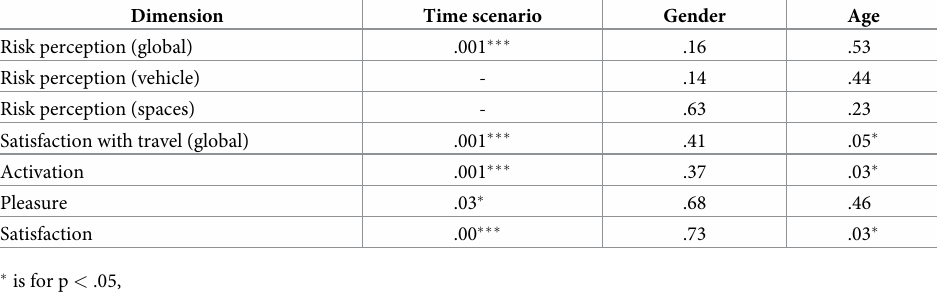
Table 8. Effects of the variables time scenario, gender and age on risk perception (global and two subscales) and satisfaction with travel (global and three